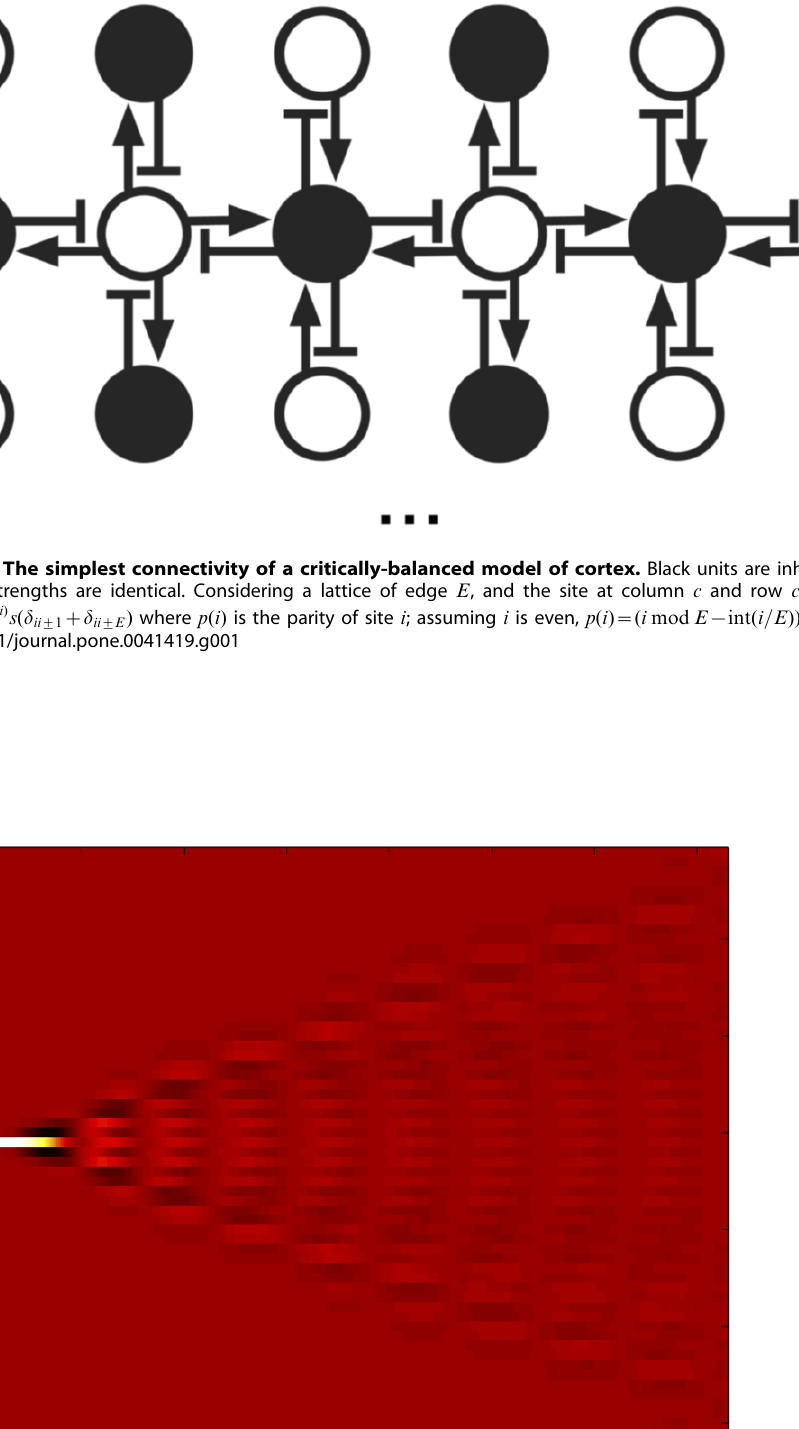
PLoS ONE | www.plosone.org